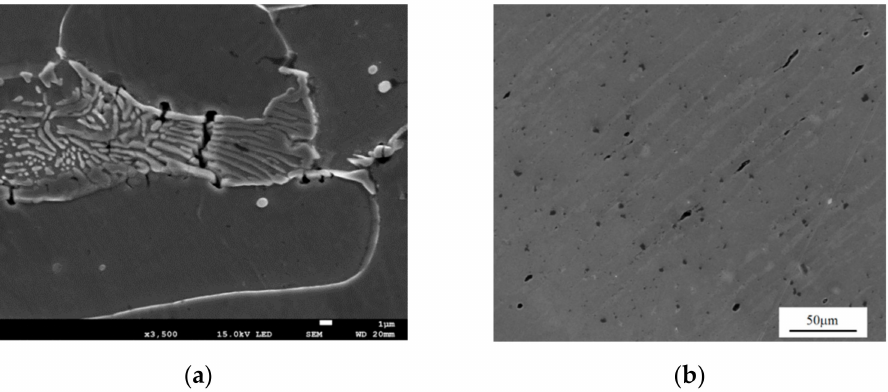
Figure 4. ( a ) Microdamage and voids inside and on the boundaries of the grains; ( b ) an example of impurities in the microstructure of S355